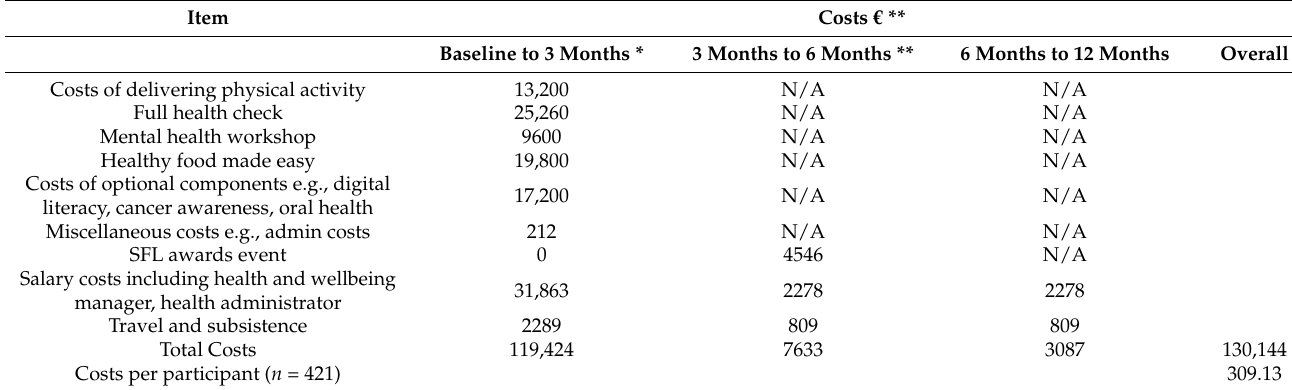
Table 1. Costs of the Sheds for Life program.